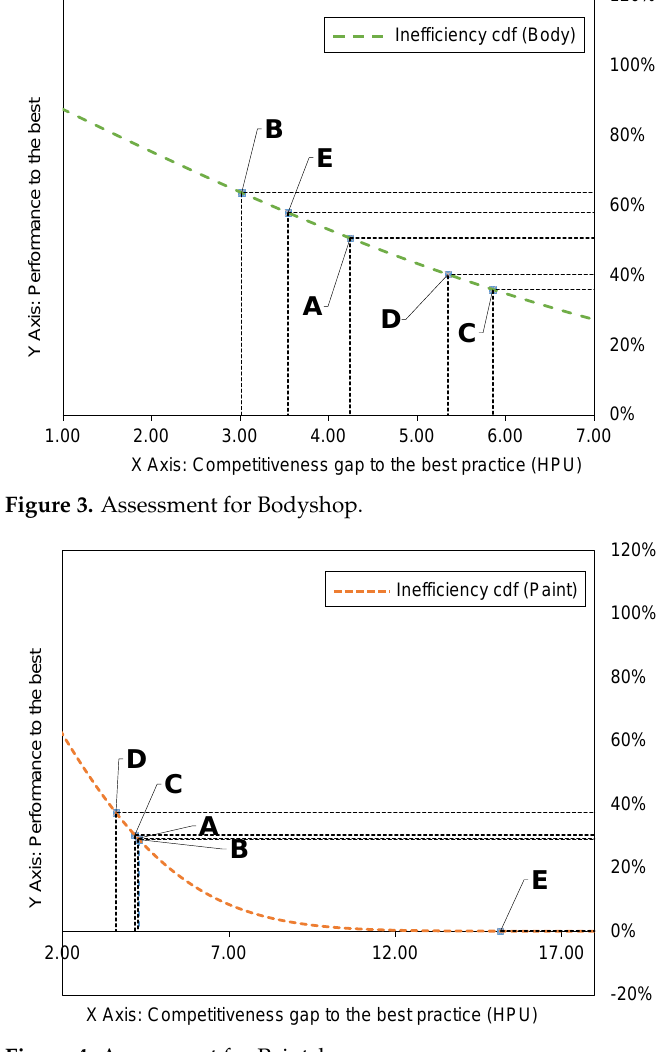
Figure 4. Assessment for Paintshop.